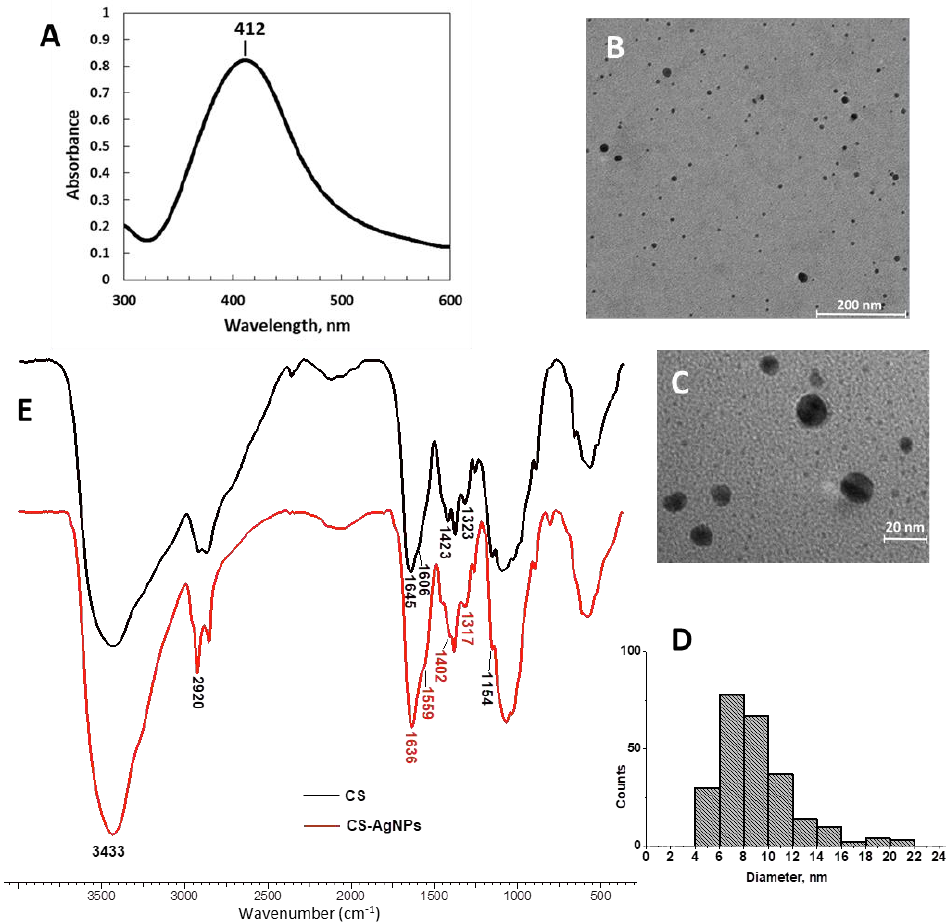
Figure 1. UV–Vis absorption spectra ( A ), TEM images ( B , C ), and the size histogram for the CS-AgNPs ( D ). FT-IR spectra of CS (black) and CS-AgNPs (red) ( E ).